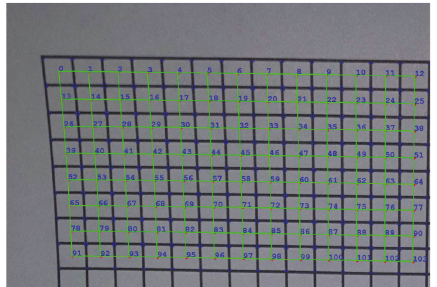
Figure 7: The grid pattern printed on a paper. Note that the blue lines are a bit curved.